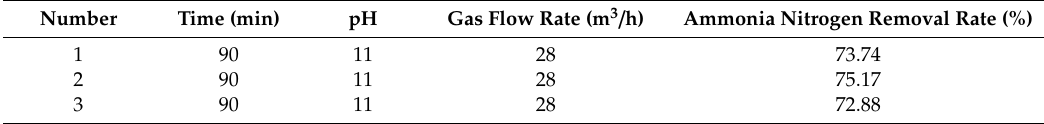
Table 5. Conditions and results of the verification